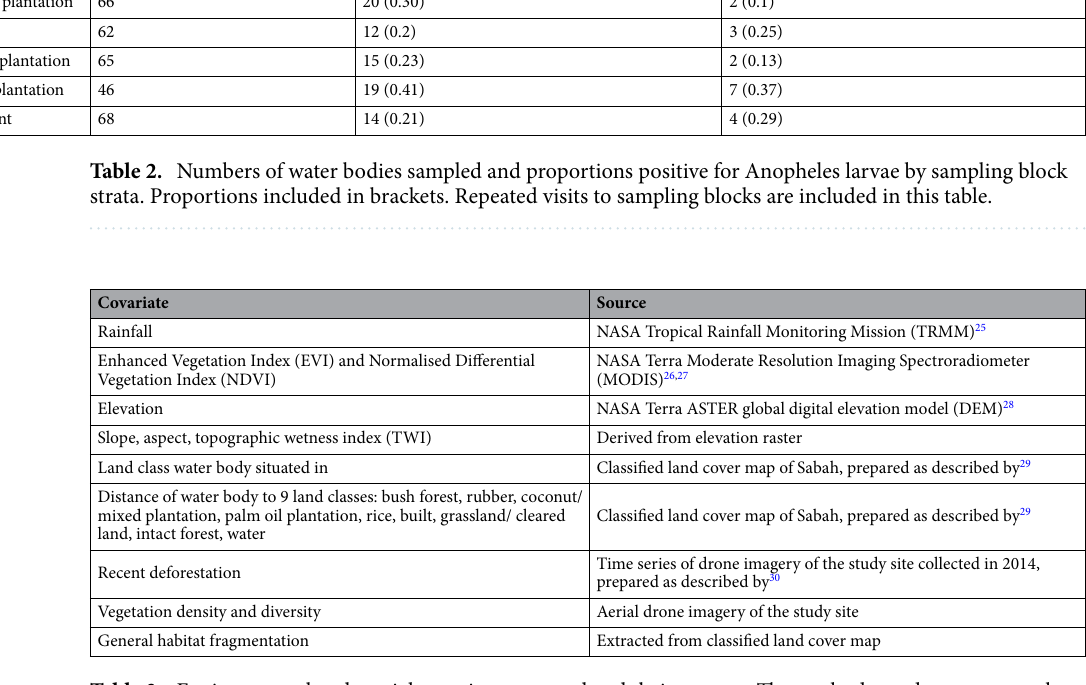
Table 3. Environmental and spatial covariates assessed and their sources. The methods used to extract each covariate from their corresponding raster are described in Supplementary Information Table